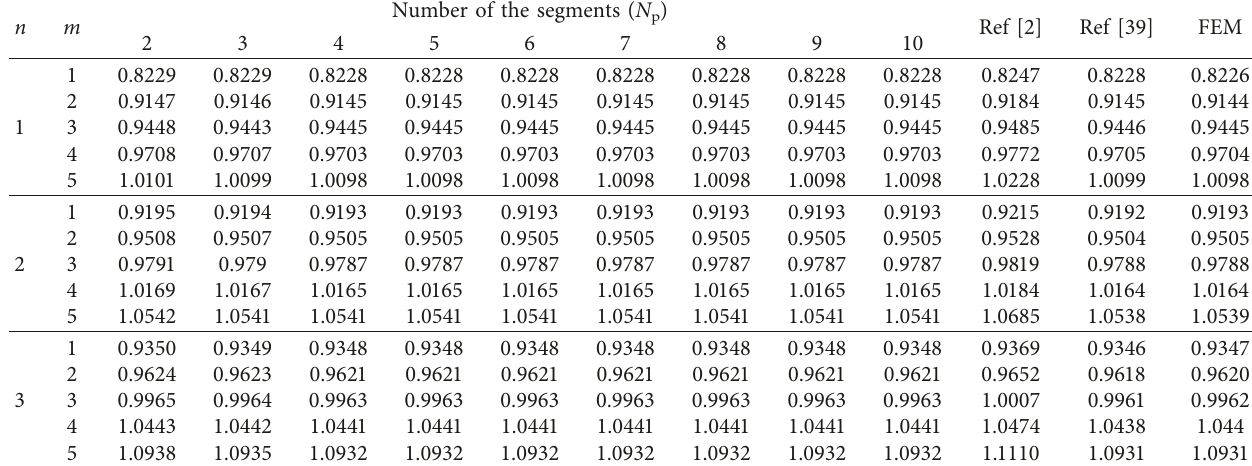
􏽰 ���������� with respect to the section number of spherical cap ( N p ρ ( 1 − μ 2 ) / E S